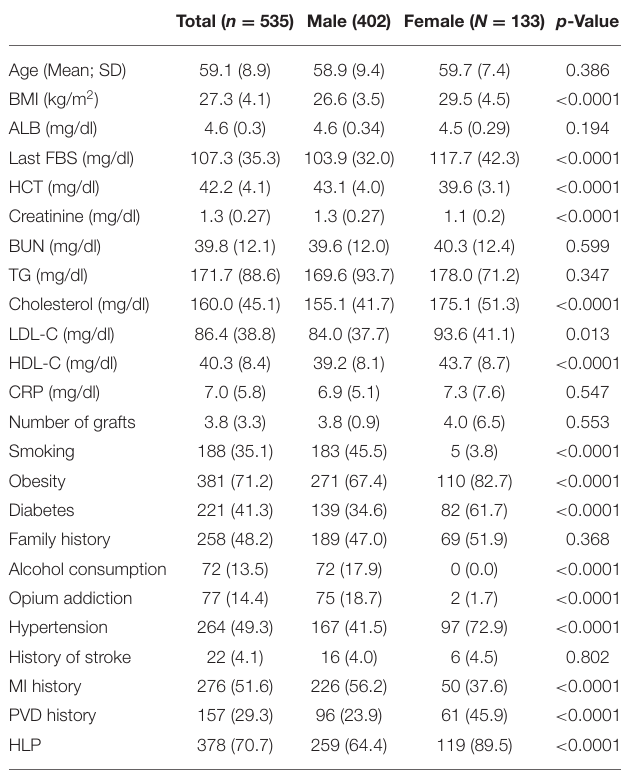
TABLE 1 | Demographic, clinical, and preclinical parameters of the